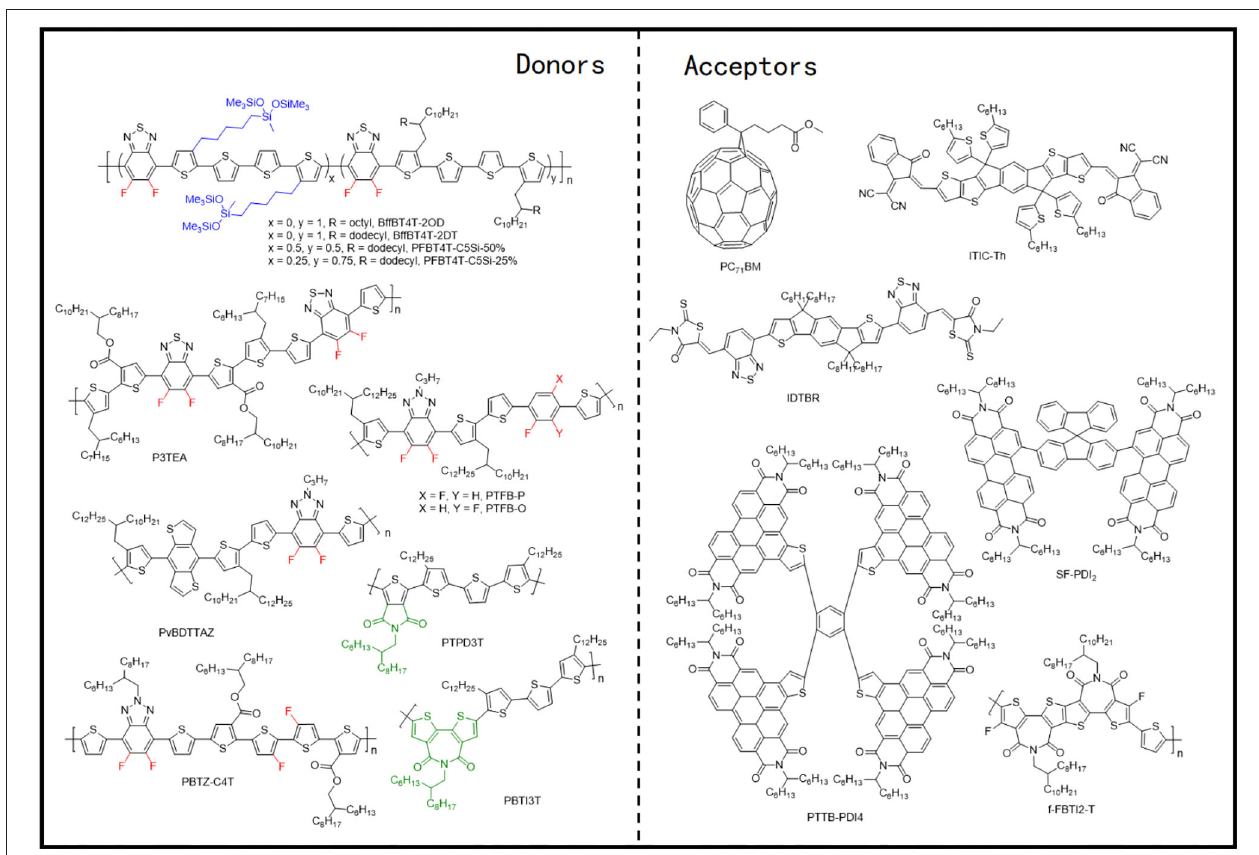
FIGURE 10 | Molecular structures of representative copolymers of the electron-deficient unit and bithiophene and mentioned